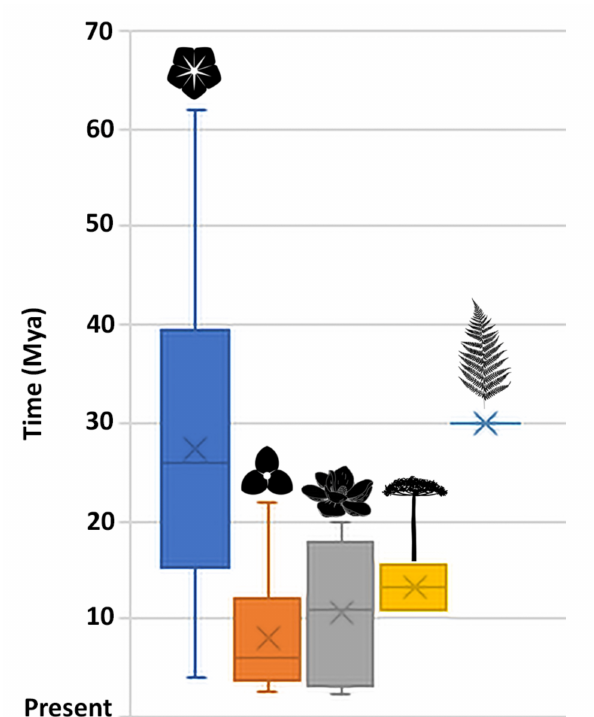
Figure 4. Box plots summarizing the diversification of vascular plants through time in the Brazilian Atlantic Rainforest based on data presented in Table 2. (blue) Eudicots; (orange) Monocots; (gray)–Magnoliids; (yellow) Gymnosperms; (light blue)